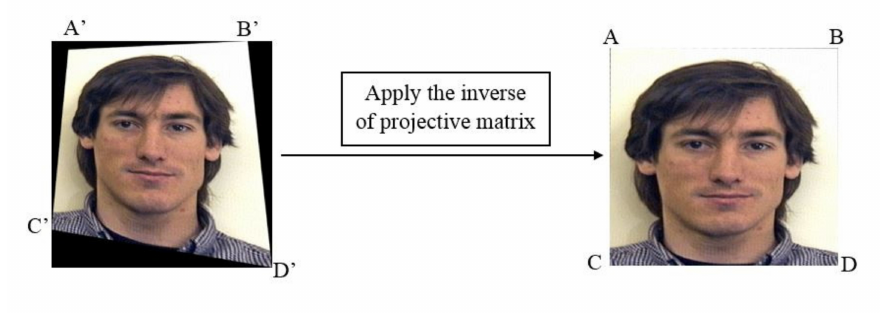
Figure 4. Projective